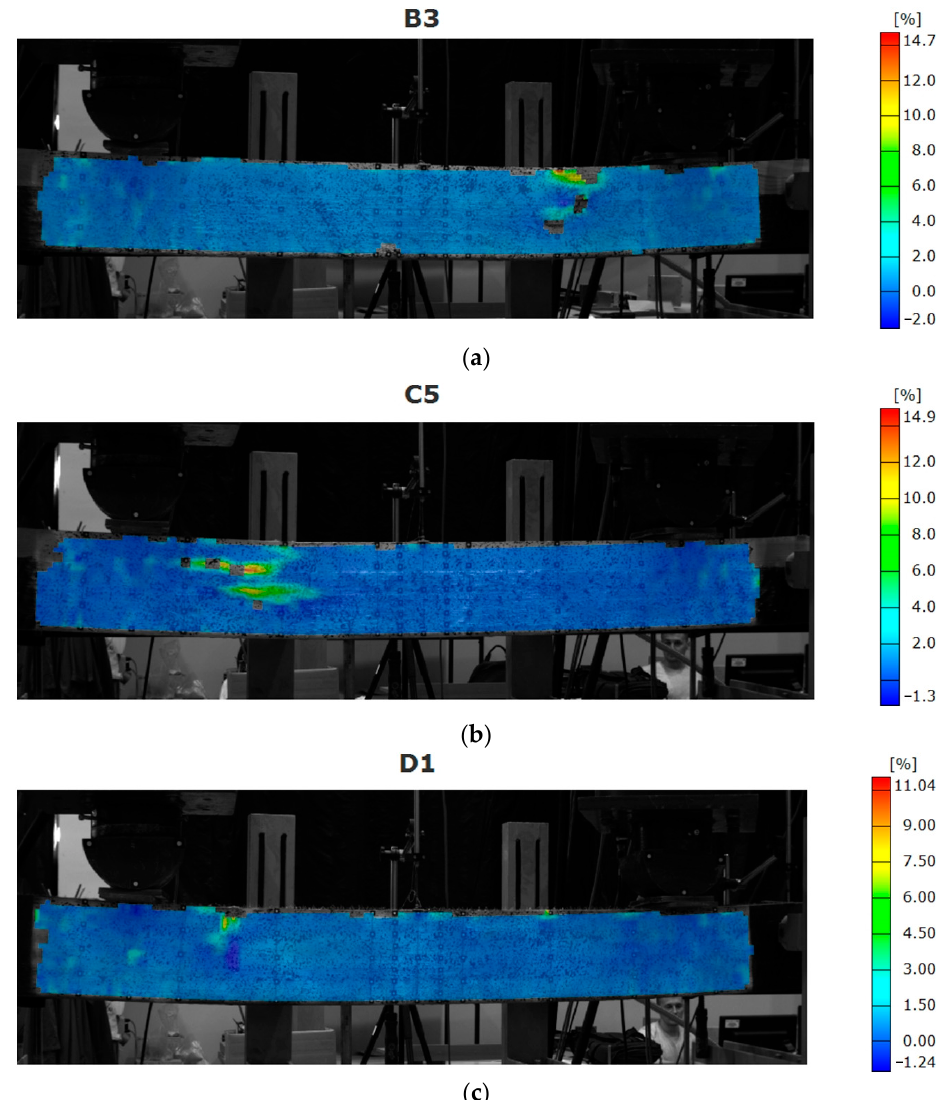
Figure 15. Map of strain distribution for beams strengthened with CFRP sheets: ( a ) B3 (one layer of CFRP sheet); ( b ) C5 (two layers of CFRP sheet bonded one on another); ( c ) D1 (two layers of CFRP sheet covering entire side surface).